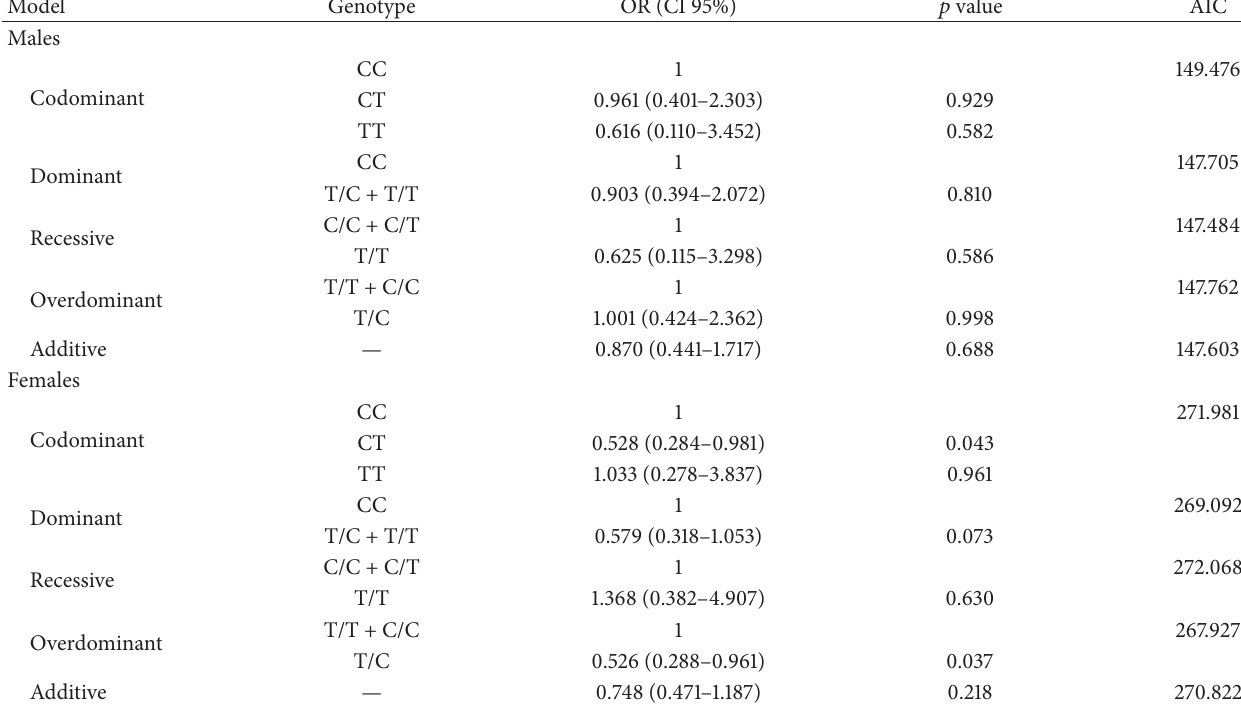
Table 5: Binomial logistic regression analysis in pituitary adenoma (PA) and the control women by gender.